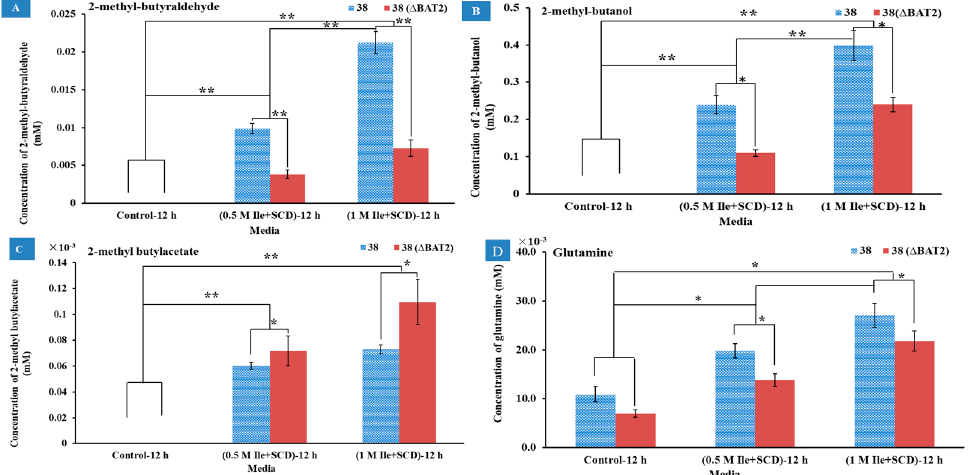
Figure 3. The effects of Ile addition amount in media and BAT2 gene deletion on the metabolites. ( A ) The effects of Ile addition amount in media and BAT2 gene deletion on the yields of 2-methyl- butyraldehyde; ( B ) the effects of Ile addition amount in media and BAT2 gene deletion on the yields of 2-methyl-1-butanol; ( C ) the effects of Ile addition amount in media and BAT2 gene deletion on the yields of 2-methylbutyl acetate; ( D ) the effects of Ile addition amount in media and BAT2 gene deletion on the yields of glutamine. ** Extremely significant ( p ˂ 0.01, n = 3); * significant ( p ˂ 0.05, n = 3).